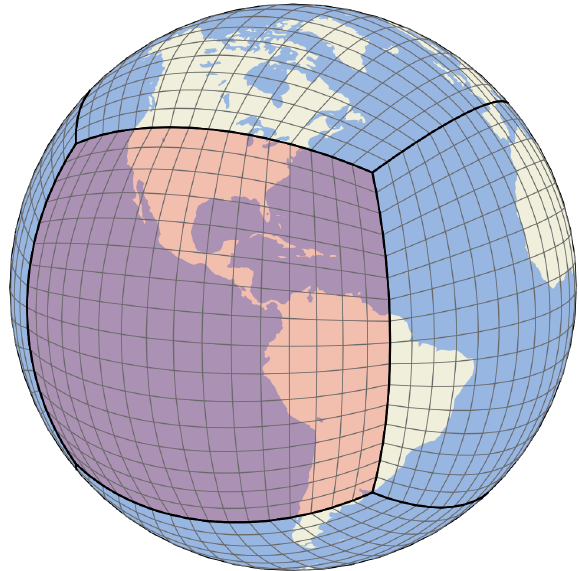
Figure 1. Illustration of a C16 grid. A cubed-sphere grid always has six faces. One of the six faces is highlighted for illustrative pur- poses. The highlighted face is a 16 × 16 grid that is regularly spaced in a gnomonic projection centered on the